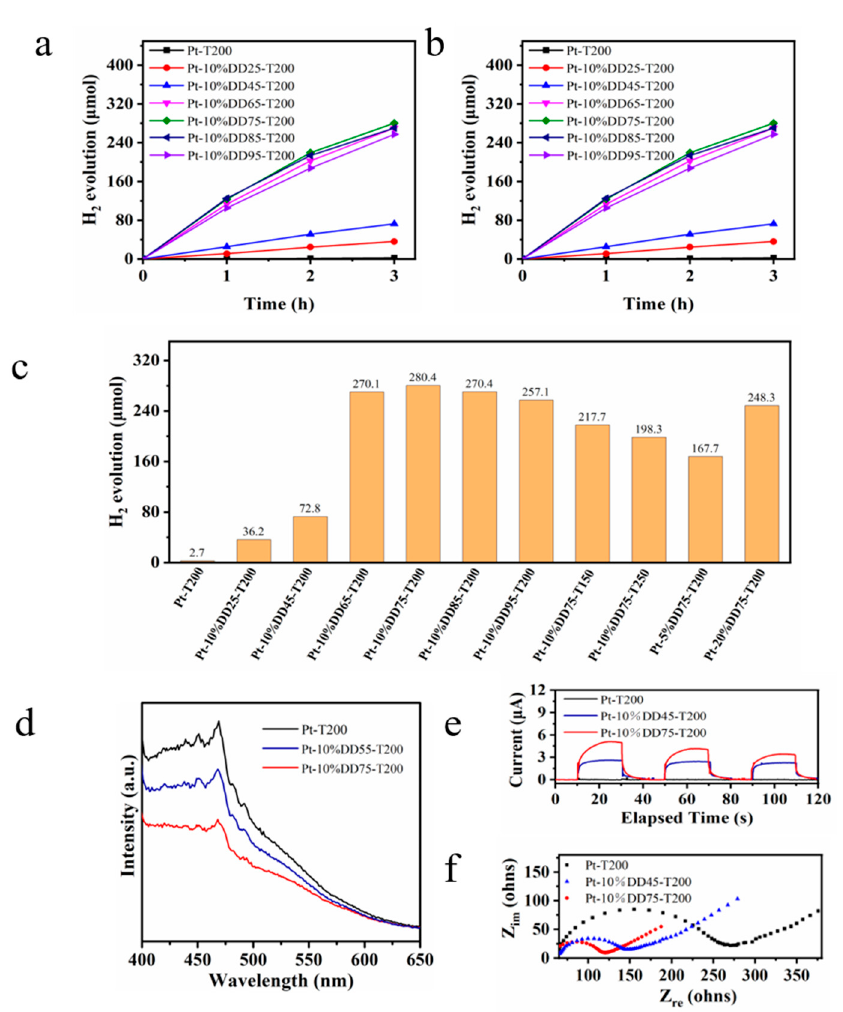
Figure 6. ( a , b ) Photocatalytic H 2 evolution, ( c ) H 2 evolution rates of as-prepared Pt-chitosan-TiO 2 samples ( λ > 420 nm, 10 vol% TEOA, pH = 11.3, 278 K), ( d ) emission spectra, ( e ) transient photocur- rent (0.1M Na 2 SO 4 , Ag/AgCl electrode, Pt plate, sample electrodes, pH = 11.3, 0 V), ( f ) EIS Nyquist plots of Pt-T200, Pt-10%DD45-T200, and Pt-10%DD75-T200 (0.1M KCl, Ag/AgCl electrode, Pt plate, sample electrodes, pH = 11.3, 0.2 V). 2.3. Mechanism of Photocatalytic Reaction Based on the above analysis and experimental results, a possible photocatalytic mechanism for water reduction over Pt-chitosan-TiO 2 CT complex photocatalyst was pro- posed (Figure 7). In this process, chitosan attaches to the TiO 2 surface through their hy- droxyl groups, sensitizing the TiO 2 by forming LMCT complexes. Typically, electrons can be easily excited from the HOMO level of chitosan and transferred to the CB of TiO 2 under visible-light irradiation. In addition, due to a higher work function of Pt (5.65 eV), elec- trons are transferred to the Pt cocatalyst and then react with H + to form H 2 . TEOA plays a role as a hole scavenger for the reaction.